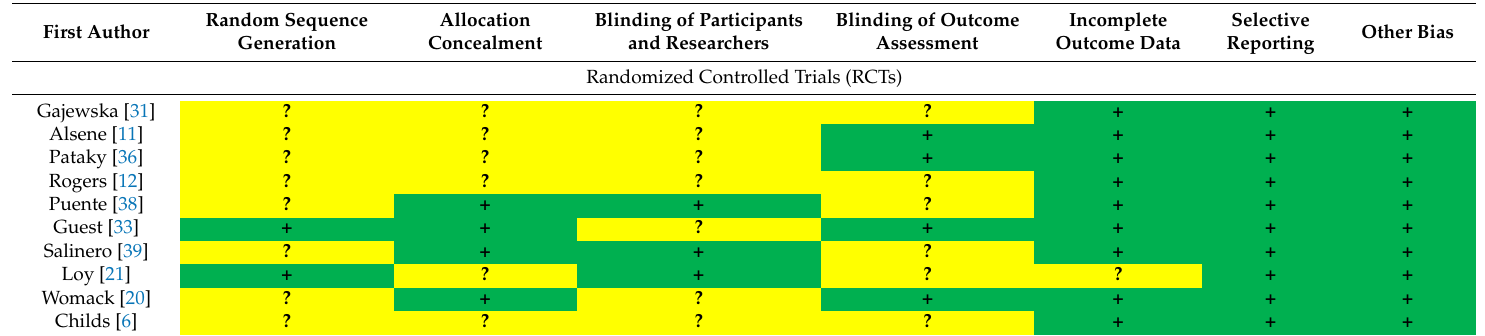
Table 2. Risk of bias assessment using the Cochrane Collaboration’s Tool.